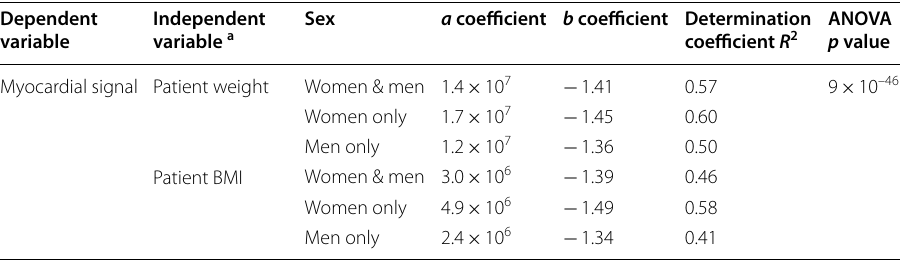
ANOVA, analysis of variance; BMI, body mass index a These correlations were measured in all patients in the 294‑patient cohort, or only the women or men